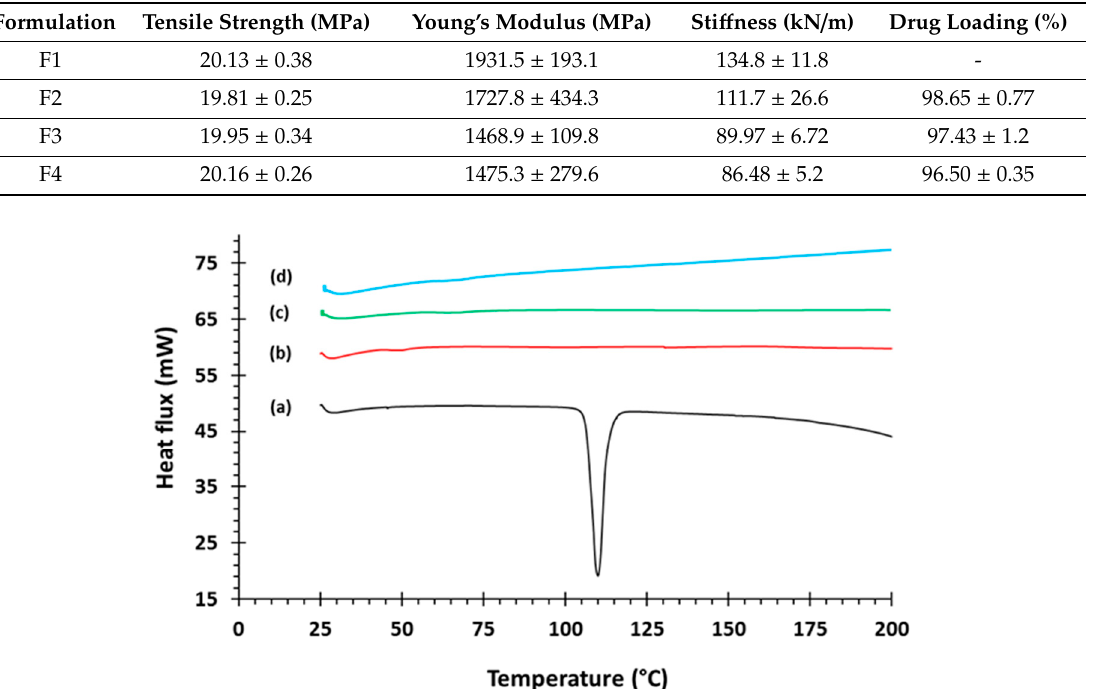
Figure 1. Differential scanning calorimetry (DSC) pattern of (a) captopril API (b) F2, (c) F3, and (d) F4.